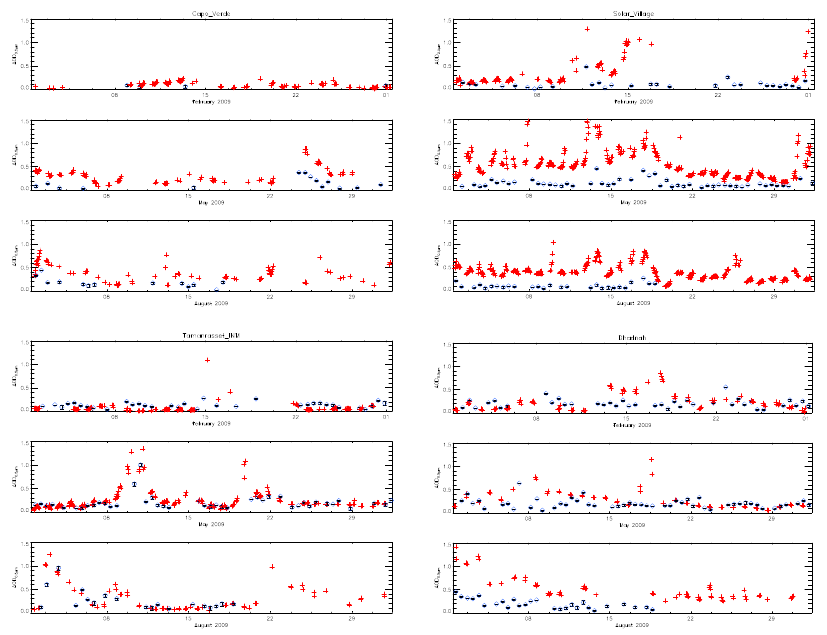
Fig. 9. Time series of AERONET coarse mode (red) and IASI (blue) derived AOD at the AERONET stations Capo Verde (top left), Solar Village (top right), Tamarasset (bottom left) and Dhadnah (bottom right) for the months February, May and August 2009.